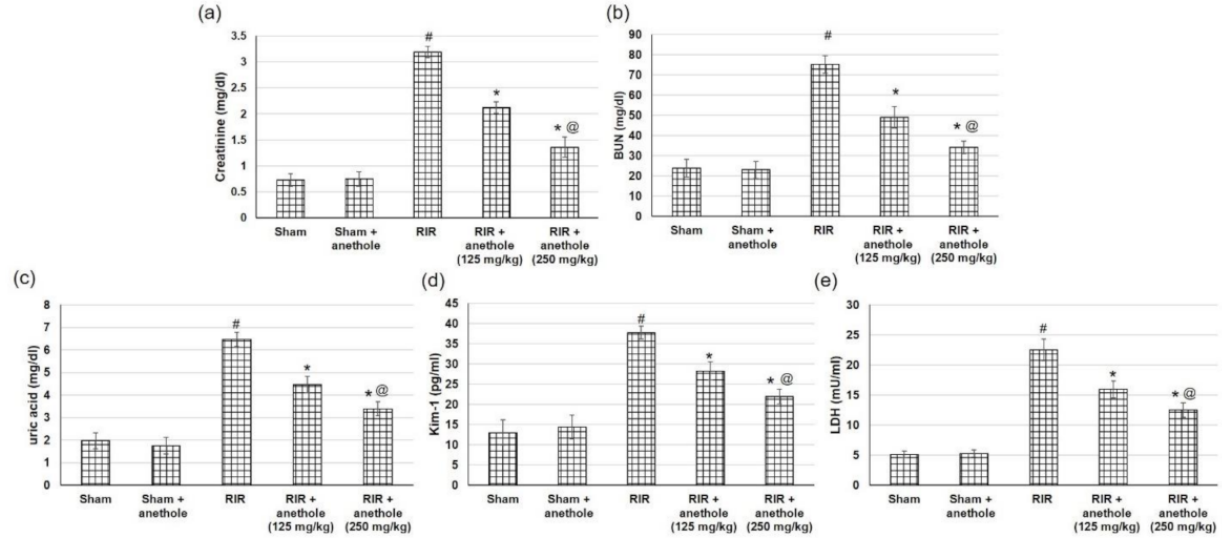
Figure 2. Effects of anethole (125 and 250 mg/kg) administration for 14 days prior to renal is- chemia/perfusion (RIR) on the renal function assessment, including ( a ) creatinine, ( b ) BUN, ( c ) uric acid, ( d ) Kim-1, and ( e ) LDH in RIR-induced injury. All values are stated as mean ± SD. # designates statistically significant compared to sham group, * designates statistically significant compared to RIR group, and @ designates statistically significant compared to RIR + anethole 125 mg/kg group ( p < 0.05) using one-way ANOVA followed by Tukey’s post hoc